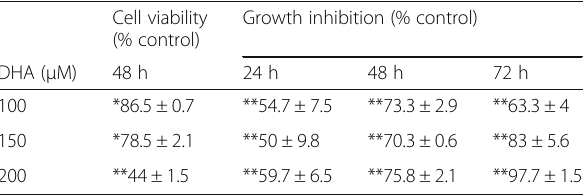
Table 2 Evaluation of cell viability and growth-inhibition rates in DHA-treated cells